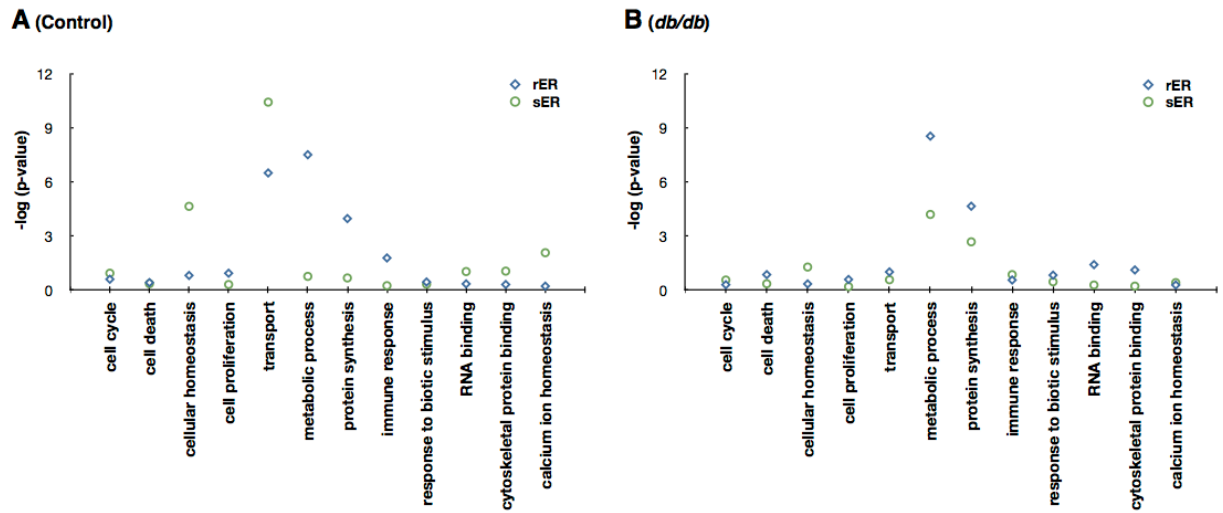
Figure 4. Functional distribution of proteins among unique proteins of the rER and sER using Gene Ontology (GO) annotation with the hypergeometric test. ( A ) C57 control mice livers; ( B ) db/db mice livers. Unique proteins showing that the expression levels are higher at least 1.5-fold in each fraction were used for analysis (for C57 rER, 214 proteins; C57 sER, 166 proteins; db/db rER 148 proteins; db/db sER, 121 proteins). Proteins showing that the expression is higher or lower at least 5-fold are considered as exclusively expressed proteins in the indicated fraction. The degree of enrichment or depletion of identified proteins in a given function category is represented as − log( p